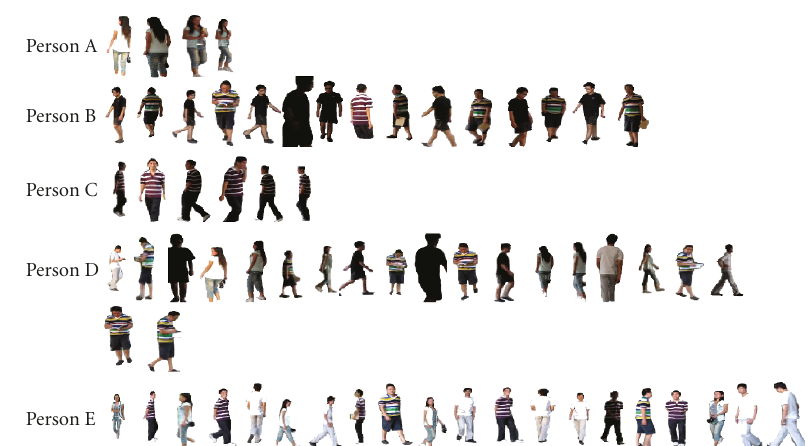
Figure 17: Trajectories recovered by EM with MCMC inference initialized by K-means clustering.